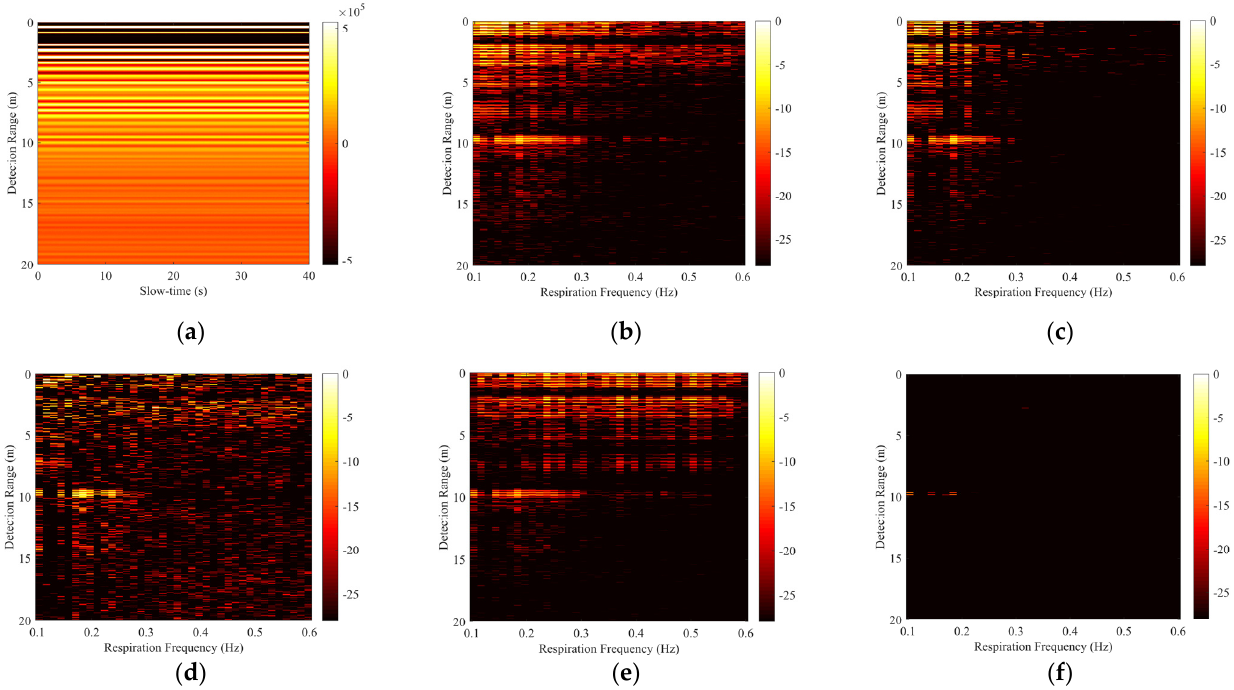
Figure 11. Realistic through-wall detection results. ( a ) The raw echo matrix, ( b ) the direct FFT result, ( c ) the result processed by MS, ( d ) the result processed by SVD, ( e ) the result processed by the method in [36], and ( f ) the result processed by our method, where λ = 0.3.